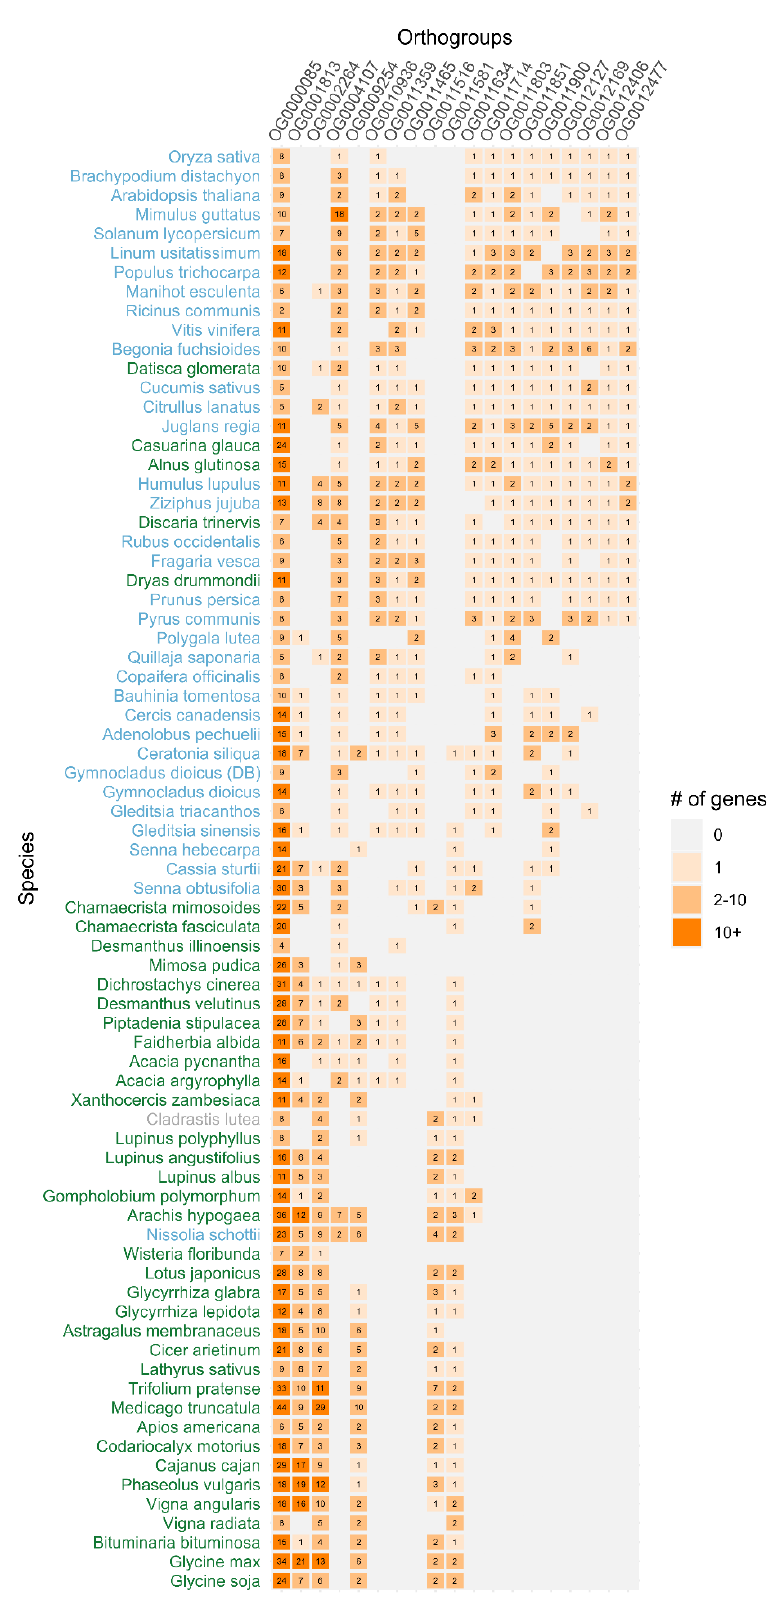
Figure 1. Representation of all genes counts for 19 orthogroups across 74 analyzed species. Font color reflects the status of nodulation for each species: green—nodulating species, blue—non nodulating species and grey – no status assigned.